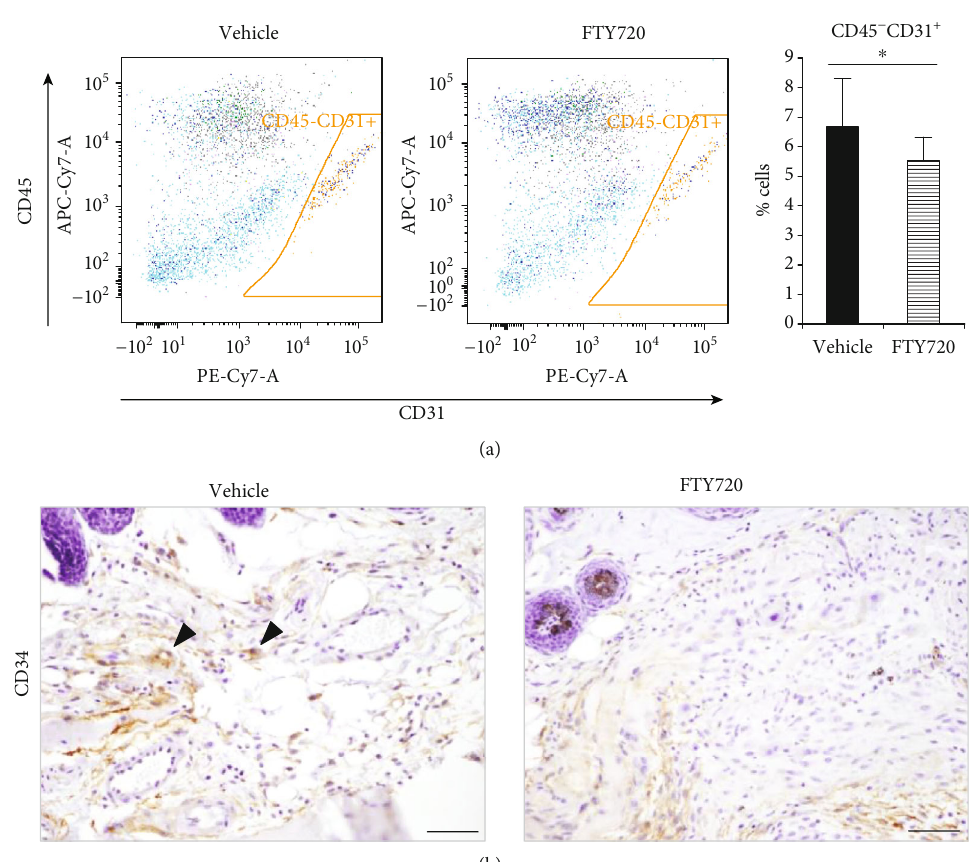
Figure 3: E ff ect of topical FTY720 injection on angiogenesis in the Day 14 scar. (a) Representative fl ow cytometric plots and the average frequencies of CD45 - CD31 + cells in the scars were determined by fl ow cytometry ( n = 14 ). Two independent experiments were performed. Both results were aggregated. (b) CD34 immunostaining images of the scars on Day 14. Arrowheads show CD34 + microvessels (scale bars: 50 μ m). All values shown represent the means ± s : e : m : ∗ p < 0 : 05 , as determined by Student ’ s t -test or Welch ’ s t -test after F test.